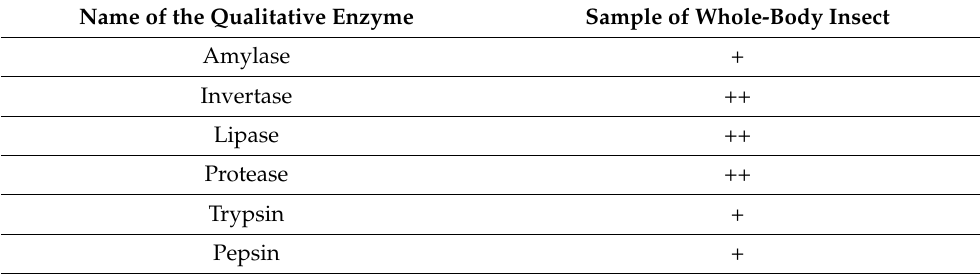
Table 2. Qualitative enzyme analysis of P. solenopsis’s whole body. Name of the Qualitative Enzyme Sample of Whole-Body Insect Amylase + Invertase ++ Lipase ++ Protease ++ Trypsin + Pepsin